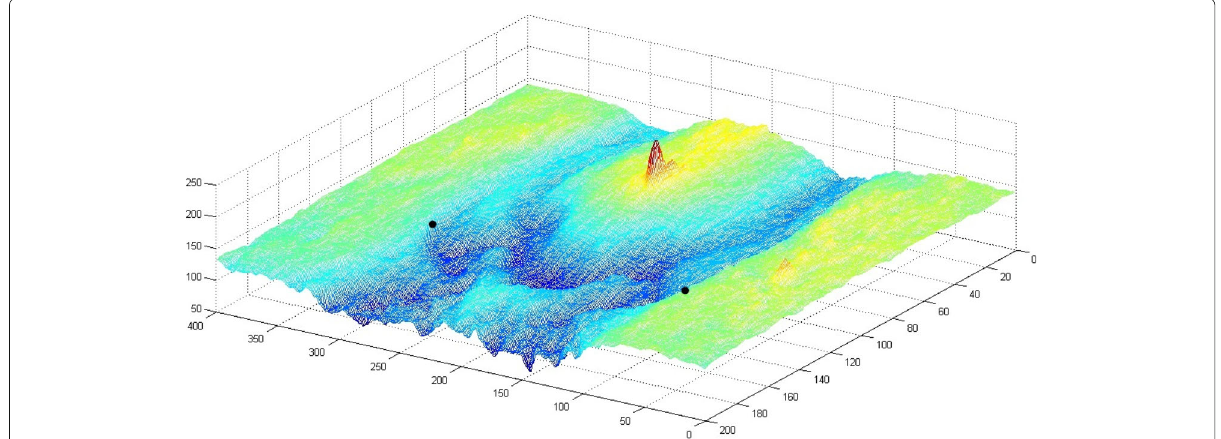
Fig. 8 Spatial visualization of the depth luminance for the area of the nose